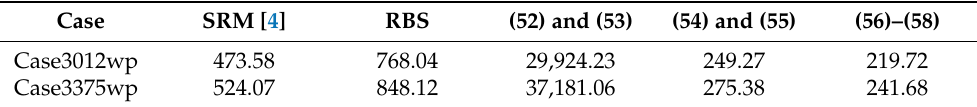
Table 10. Solution times (ms) for ill-conditioned cases with limit load conditions.